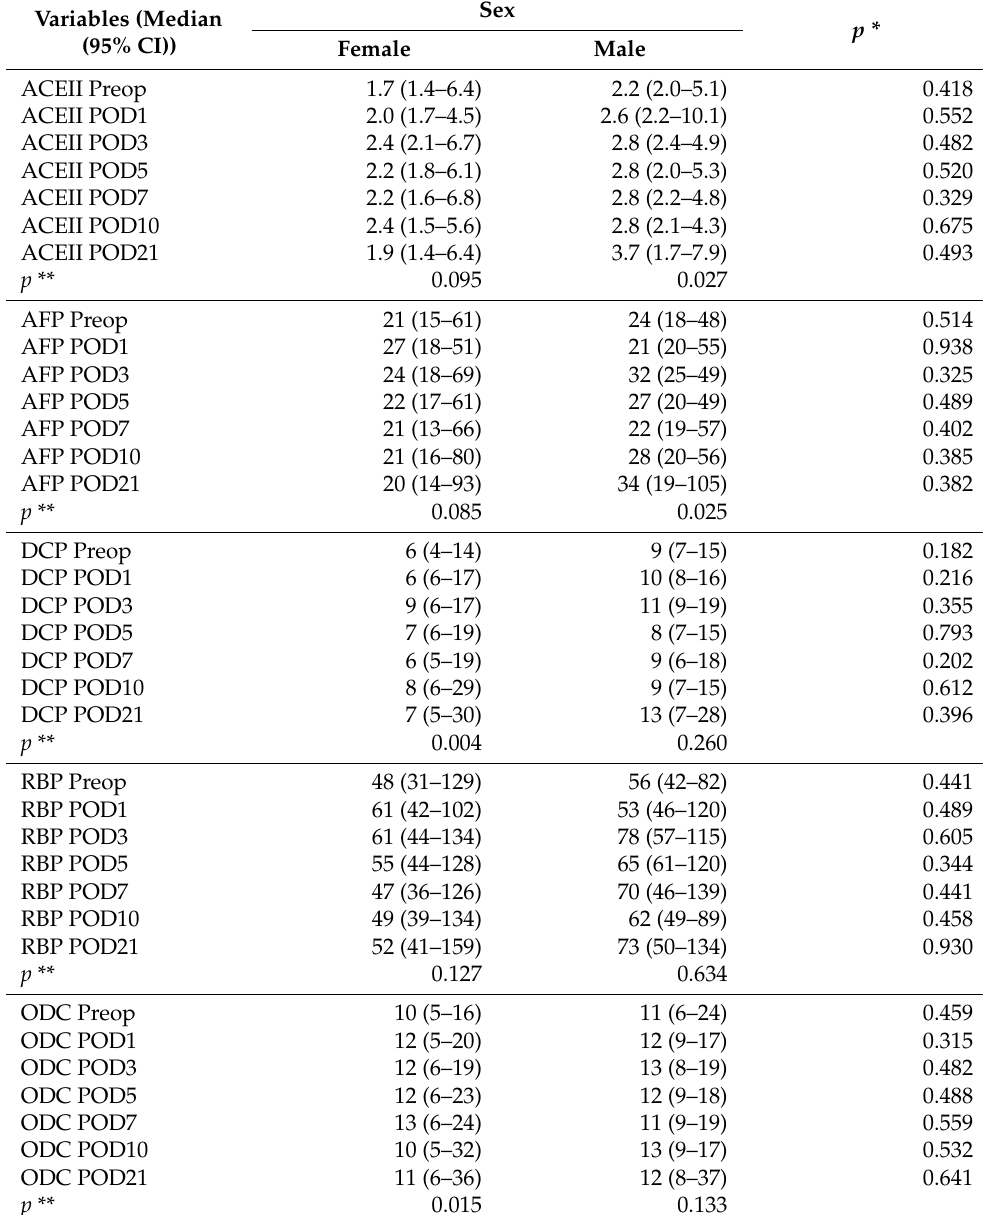
Table 8. Comparison of study subgroups created according to sex in terms of regeneration-related biochemical